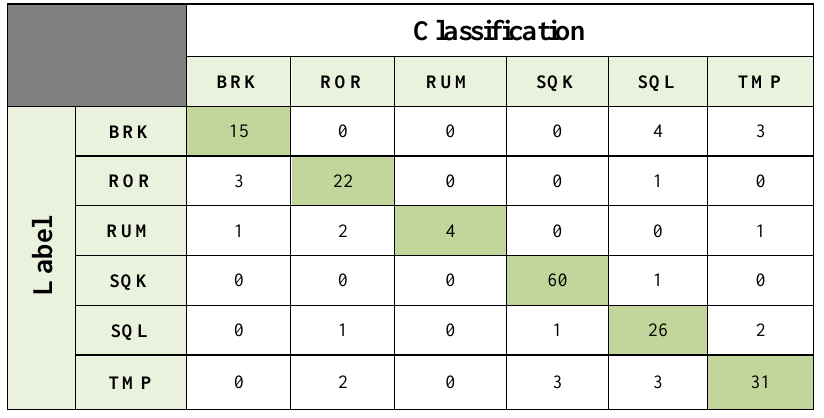
Table 2. Call type classification accuracy over reduced-set clean Asian Elephant data. Overall accuracy is 85.0% ( vs . chance accuracy